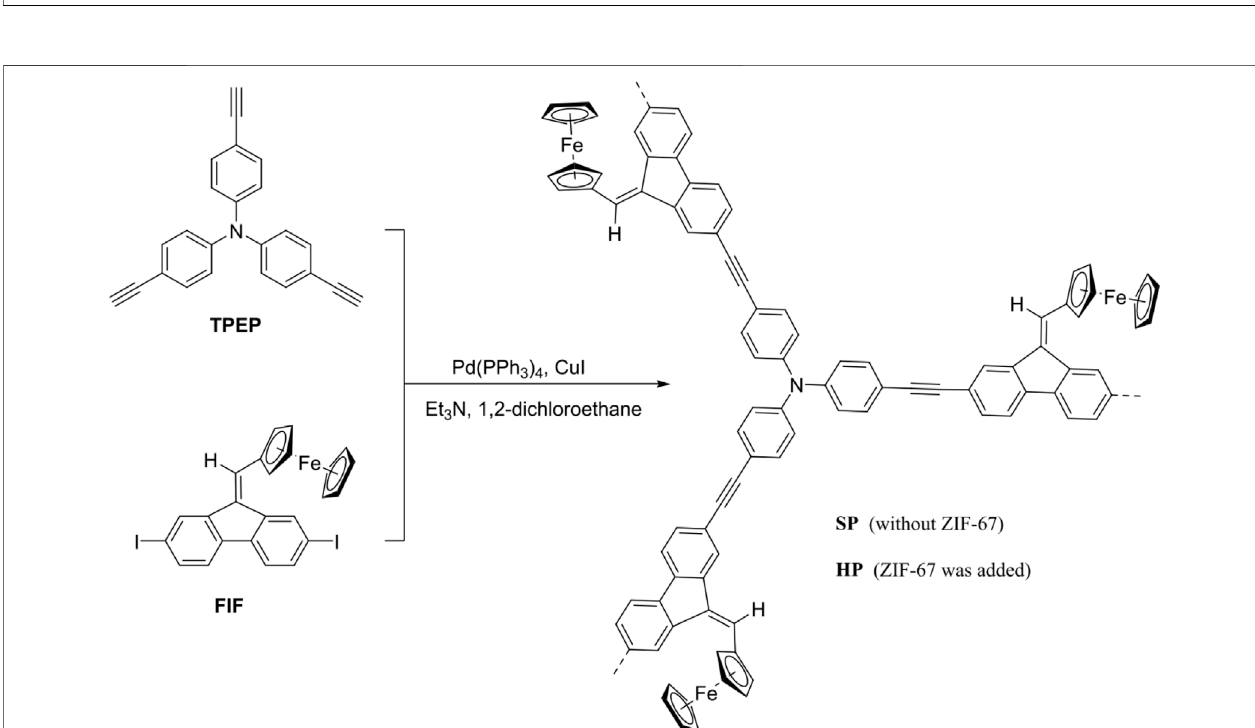
FIGURE 7 | Sonogashira coupling reaction to synthesize hyperbranched polymers (Wei et al., 2020).